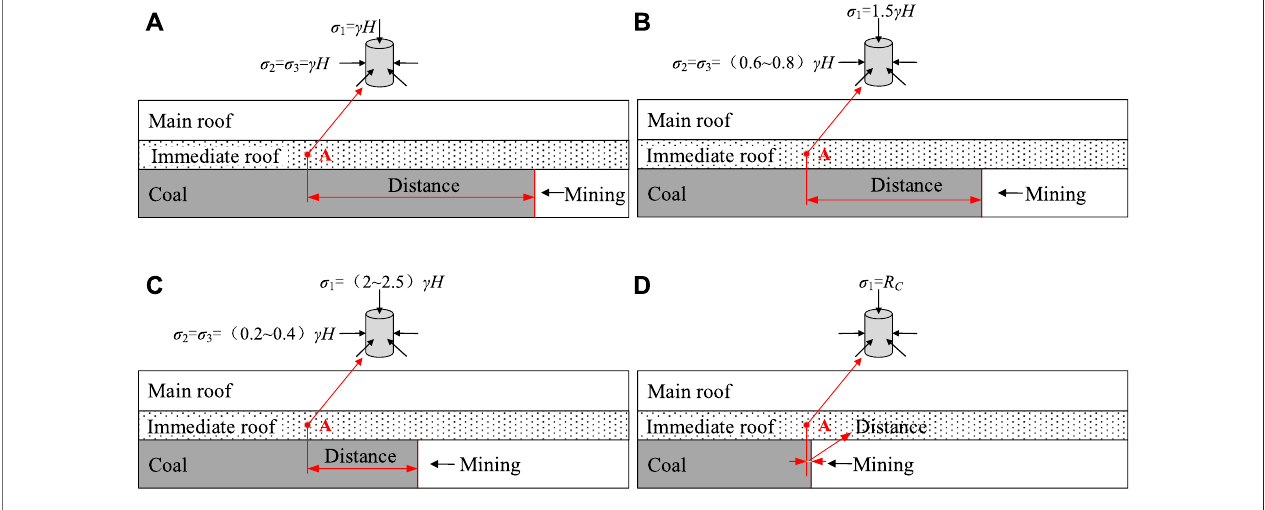
FIGURE 1 | Stress diagram of the roof in coal